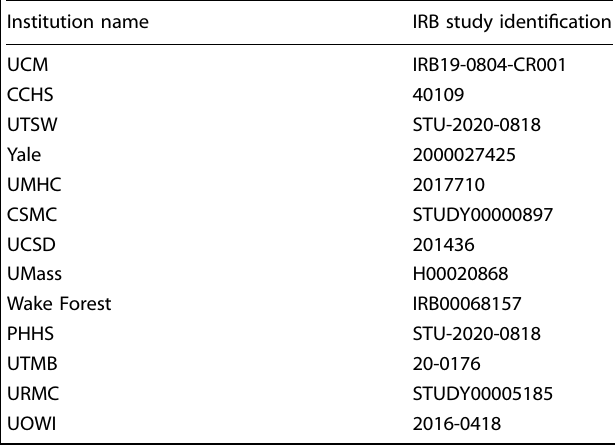
Table 5. Individual institutional review board study